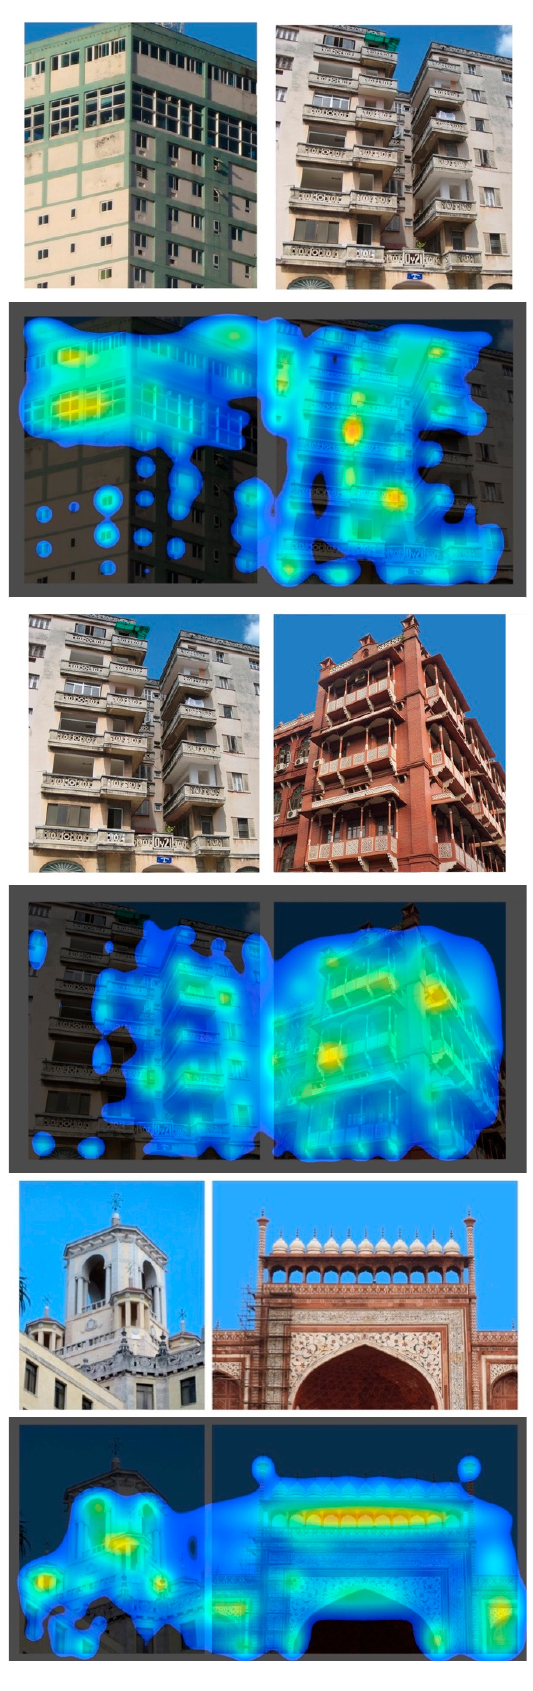
Figure 3. Pairwise comparisons of images using double VAS heatmaps processed